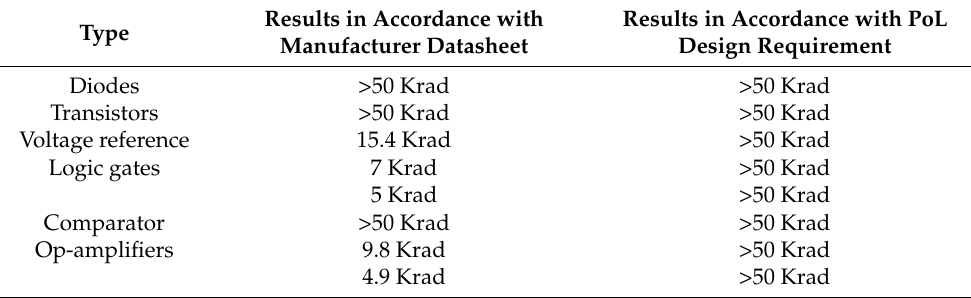
Table 1. TID status for active devices used in PoL module (from [14]).